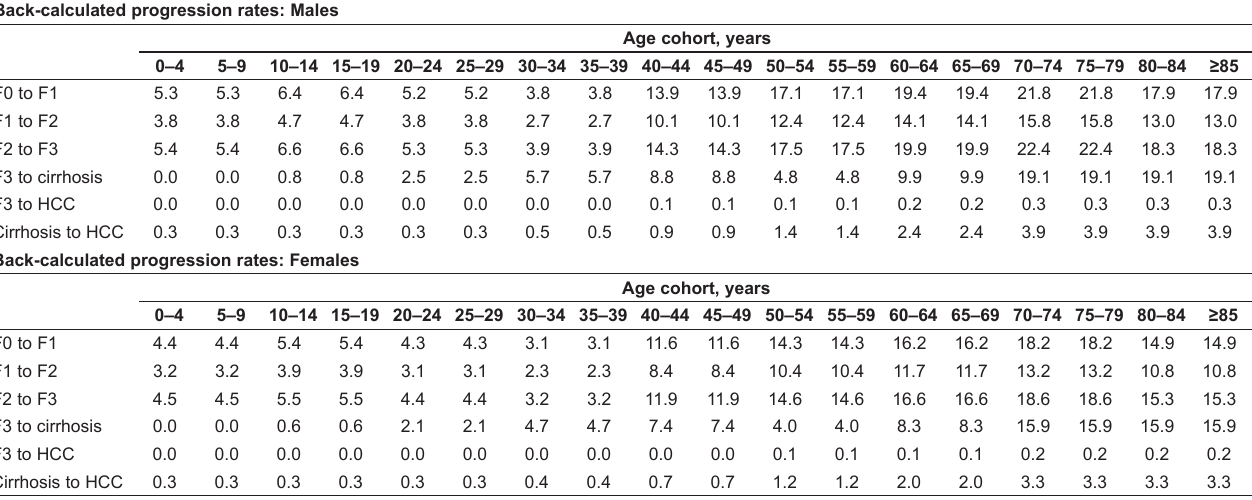
TAble 2 Hepatitis C disease progression rates used in the model back-calculated progression rates: